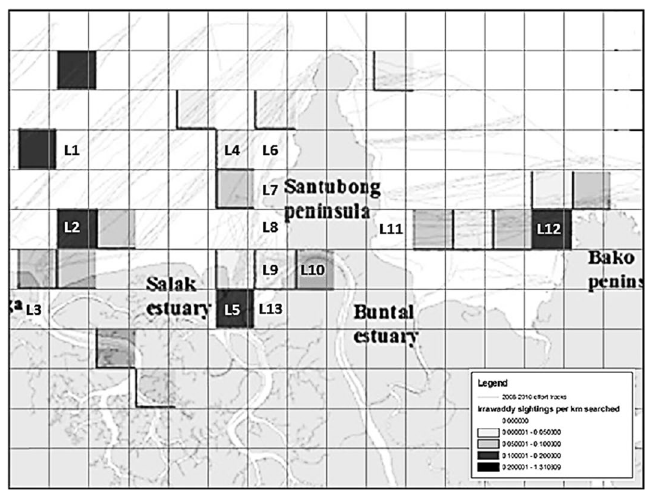
Fig. 11 Actual Location Nodes at Kuching Bay (overlaid on modified Fig. 3.5 of Peter (2012)) (Source: Liew et al. 2015a p.